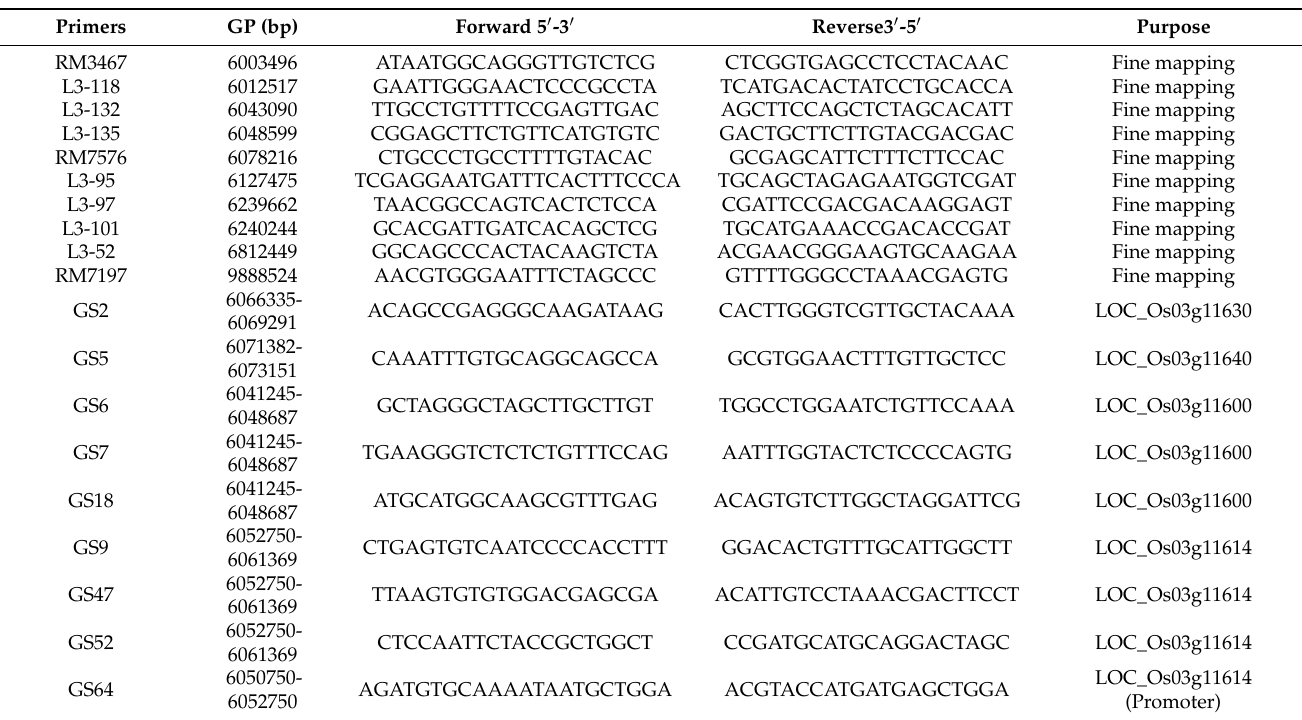
Figure 6. Localization of mp3 gene and the candidate-gene analysis. ( A ) Linkage group of mp3 gene established on the short arm of rice chromosome 3 using 22 recessive F 2 individuals. ( B ) Primary mapping of mp3 flanked by both RM3467 and RM7197 using 1417 recessive individuals. ( C ) The mp3 was fine mapped to a 30.617kb genomic interval using 44 recombinant individuals. ( D ) Four putative candidate genes were annotated in the 30.617kb genomic region. Table 4. Primers used in this study.